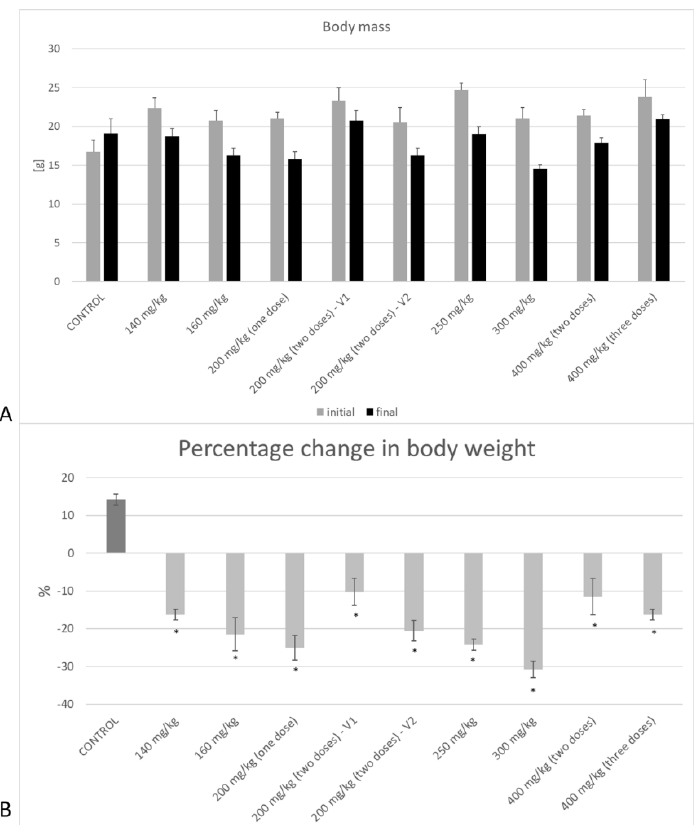
Figure 4. Change in body weight of the animals during the experiment. ( A ) The average weight of mice at time T0 on the day of starting the experiment and on the 21st day of the experiment (or on the day of death if the animals did not live to the end of the experiment). ( B ) Percentage change in body weight of tested groups with different STZ dose administration. Only the control group showed weight gain. On the other hand, all animals treated with STZ showed significant weight loss. Statistically significant values are marked with (*); p < 0.05.